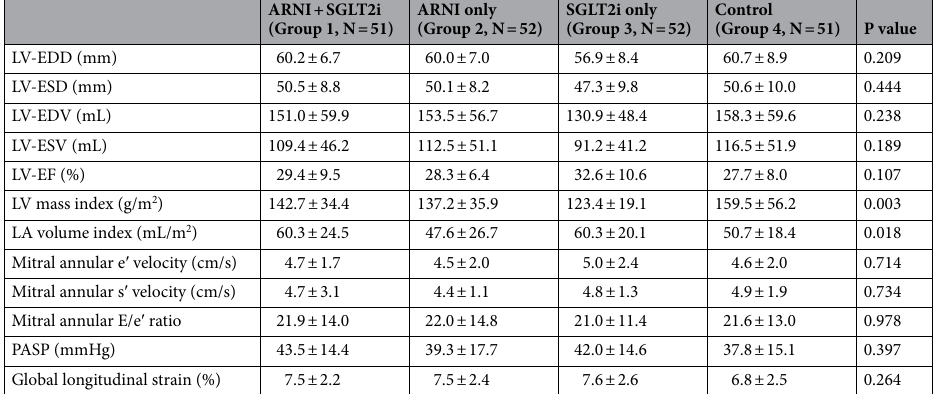
Table 2. Baseline echocardiographic parameters. LV left ventricle, EDD end diastolic dimension, ESD end systolic dimension, EDV end diastolic volume, ESV end systolic volume, EF ejection fraction, PASP pulmonary artery systolic pressure. The absolute value |x| of strain is used.